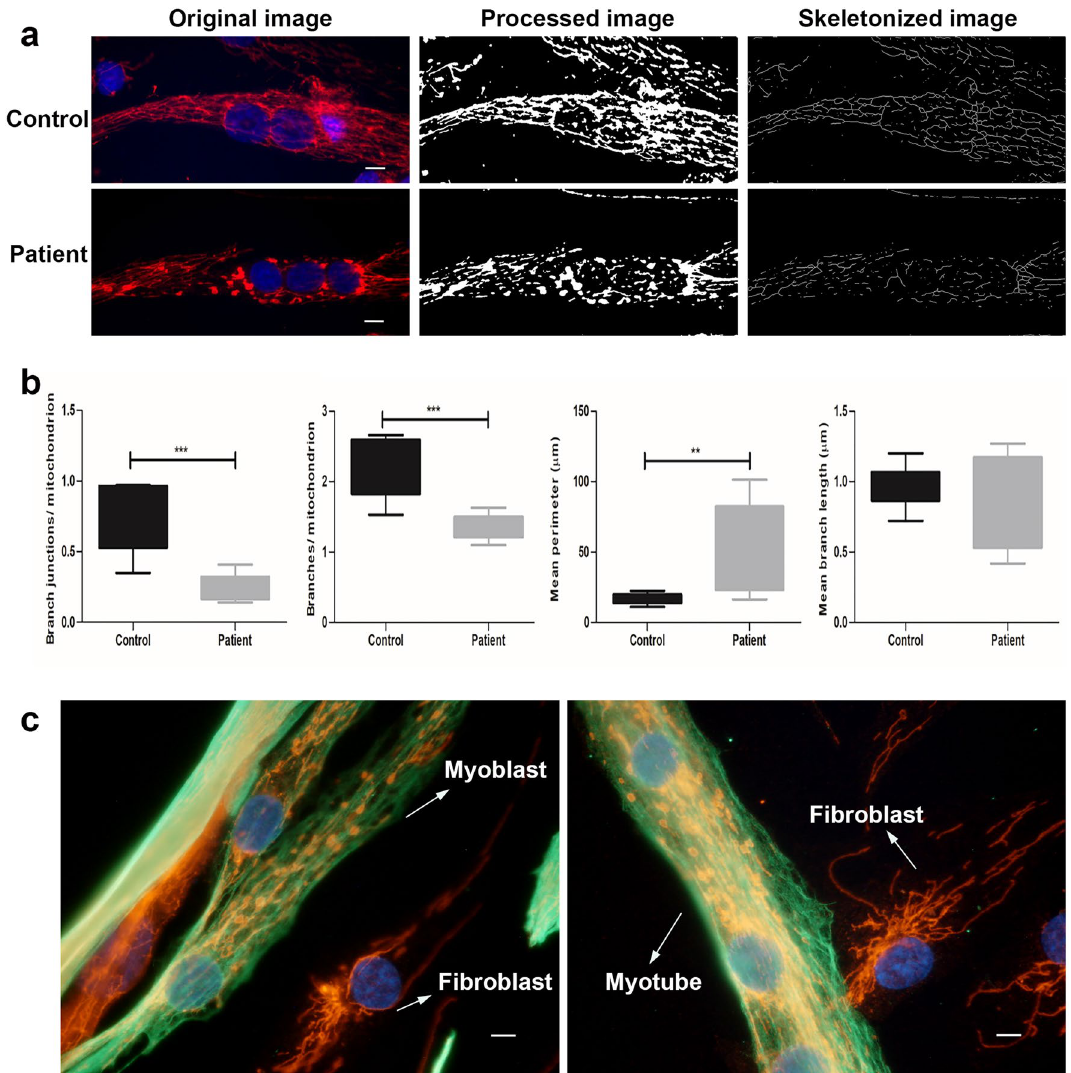
Figure 1. Mitochondrial morphology and network analysis in primary skeletal muscle cells of the Megaconial CMD patient ( a ) Immunofluorescence staining of the differentiated myotubes of the Megaconial CMD patient and the control by anti-TOM20 antibody (red), with nuclei counterstained with DAPI (blue). Original images were processed and skeletonized by ImageJ 1.53c software (NIH, https:// imagej. nih. gov/ ij/), as indicated. ( b ) Graphs showing the results of mitochondrial morphometric analysis. For all comparisons, differences between data sets were assessed by Mann–Whitney U -test with ** p < 0.01, *** p < 0.001. ( c ) Images of mitochondrial morphology and network structure in myoblasts, myotubes and fibroblasts of the Megaconial CMD patient. Green/FITC: desmin/myoblasts and myotubes; Red/Texas Red: TOM20/mitochondria; blue: DAPI/nuclei. Scale bars: 10 μm. Analysis was performed on 50 primary skeletal muscle cells in both patient and